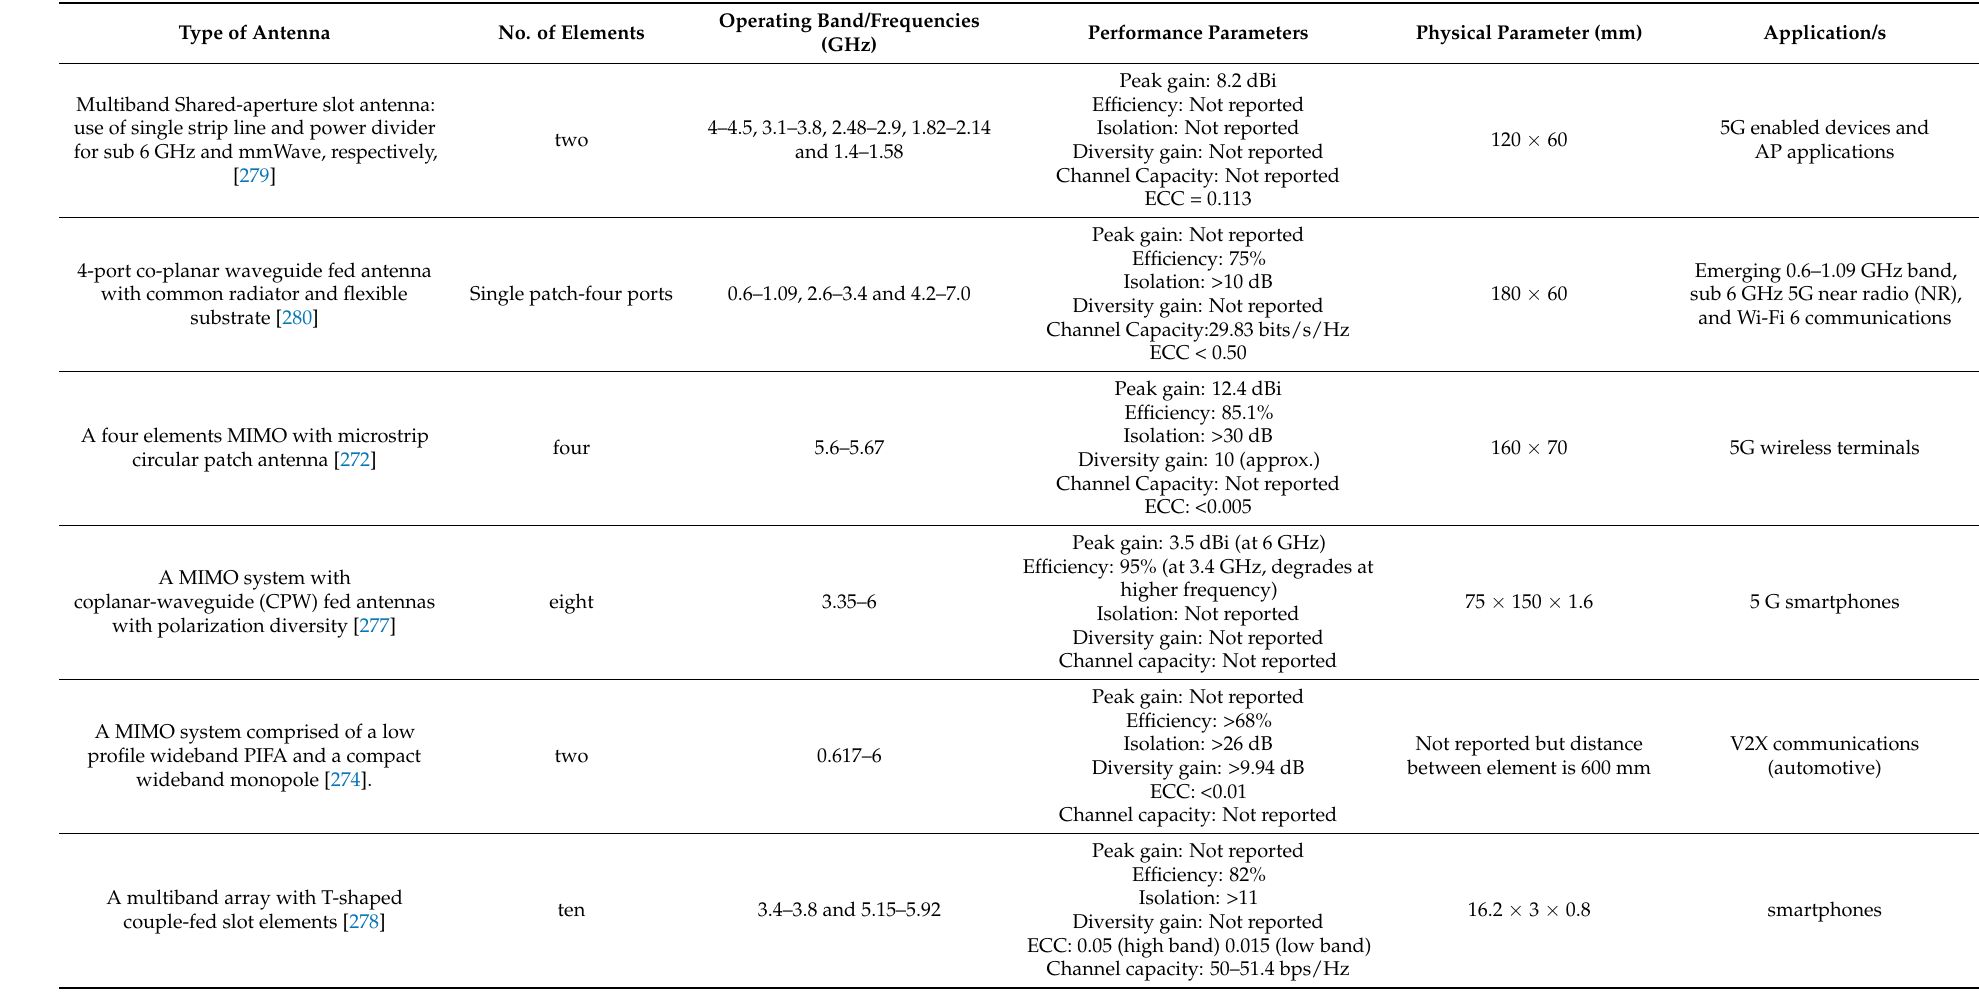
Table 14. Overview of proposed multiple antennas element systems for sub-6 GHz